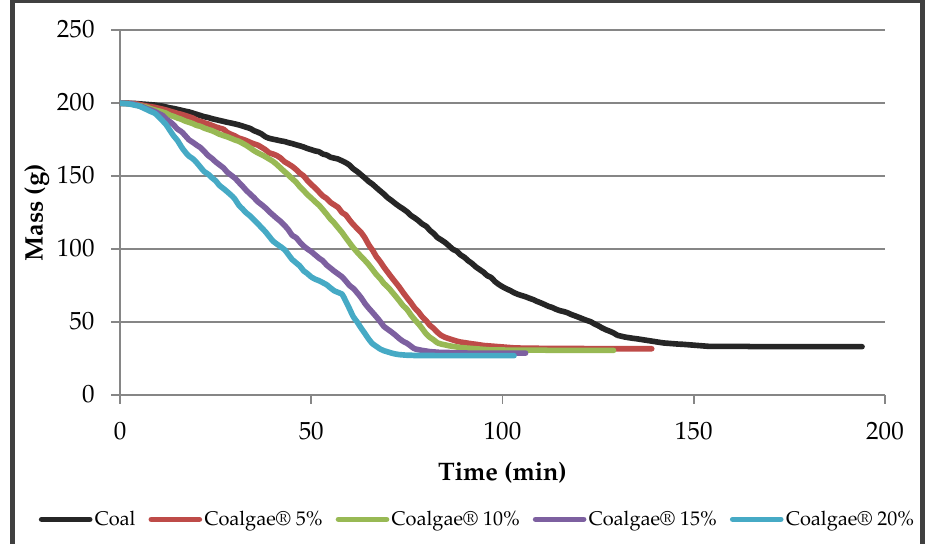
Figure 2. Mass reduction curves.